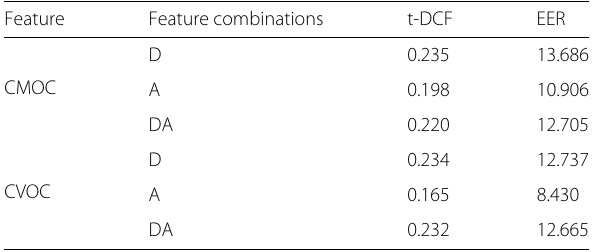
Table 8 Comparison with some known systems based on hand-crafted features on the ASVspoof 2017 V2 evaluation set in terms of EER(%)